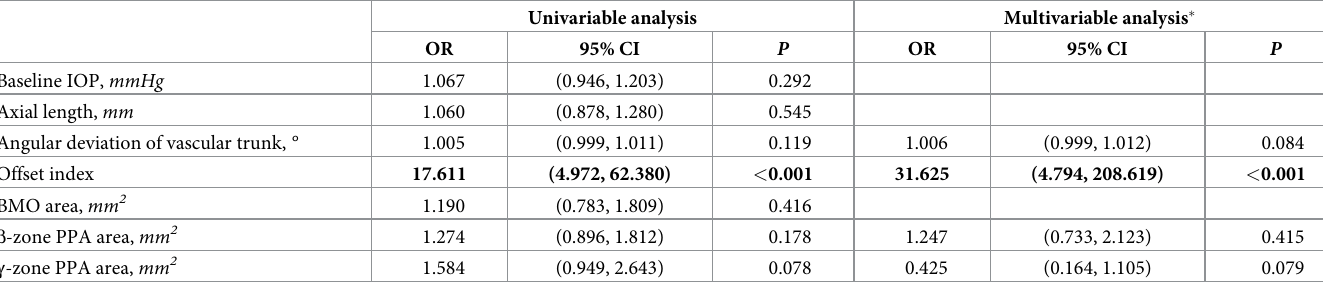
Table 2. Factors associated with presence of glaucoma within each